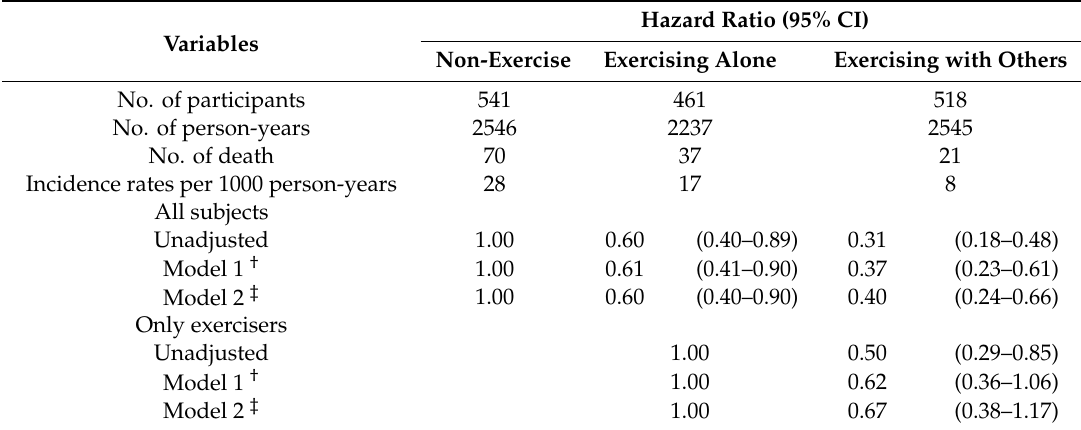
Table 3. Hazard ratios for five-year mortality by exercise habits.